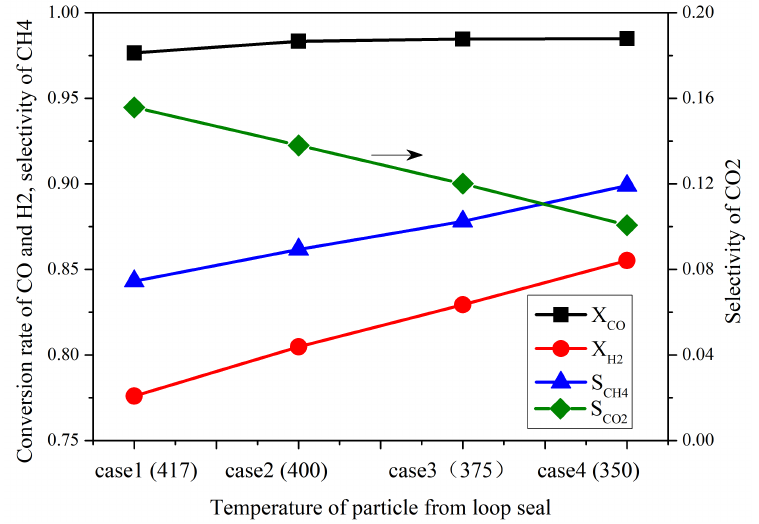
Figure 19. Conversion rate and selectivity under different cooling